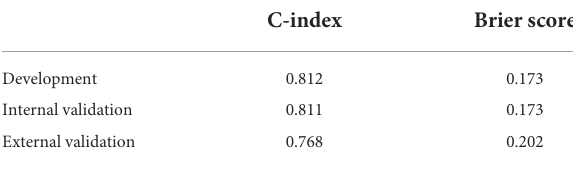
TABLE 2 The performance in model development, internal validation, and external